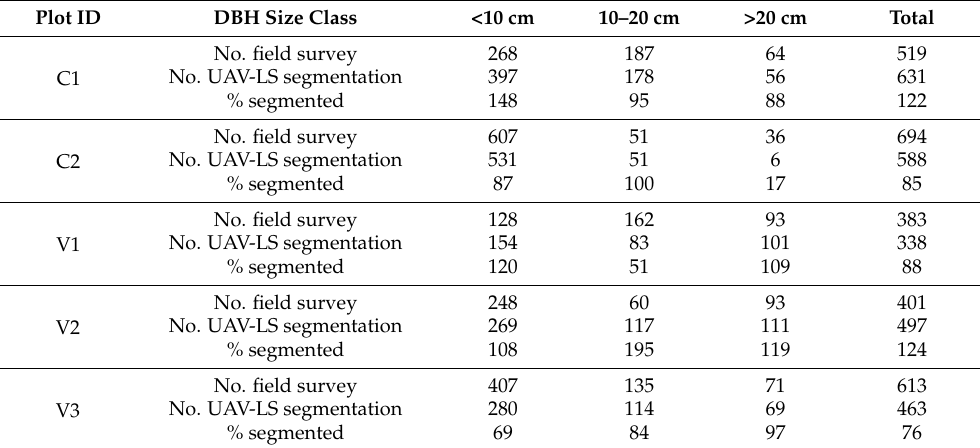
Table 2. Comparisons of field-surveyed with UAV-LS modelled number of trees in three broad size categories, <10 cm, 10–20 cm and >20 cm DBH.